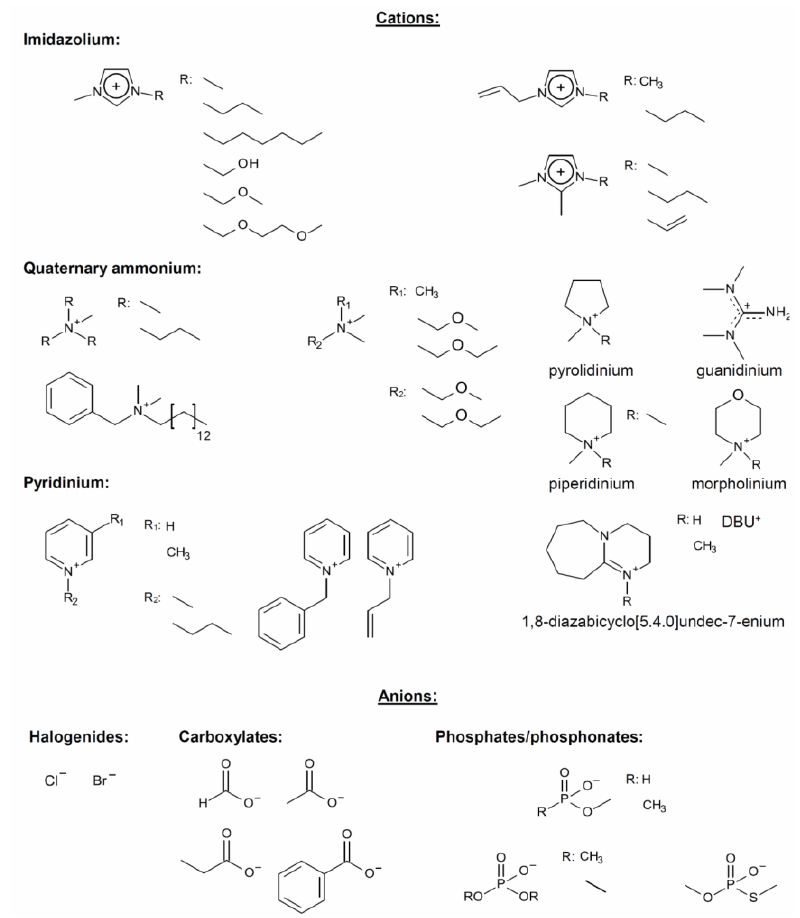
Figure 1. Molecular structures of anions and cations of typical ionic liquids employed as cellulose solvents and discussed in the present review, adapted from [5], with permission from MDPI, 2012.